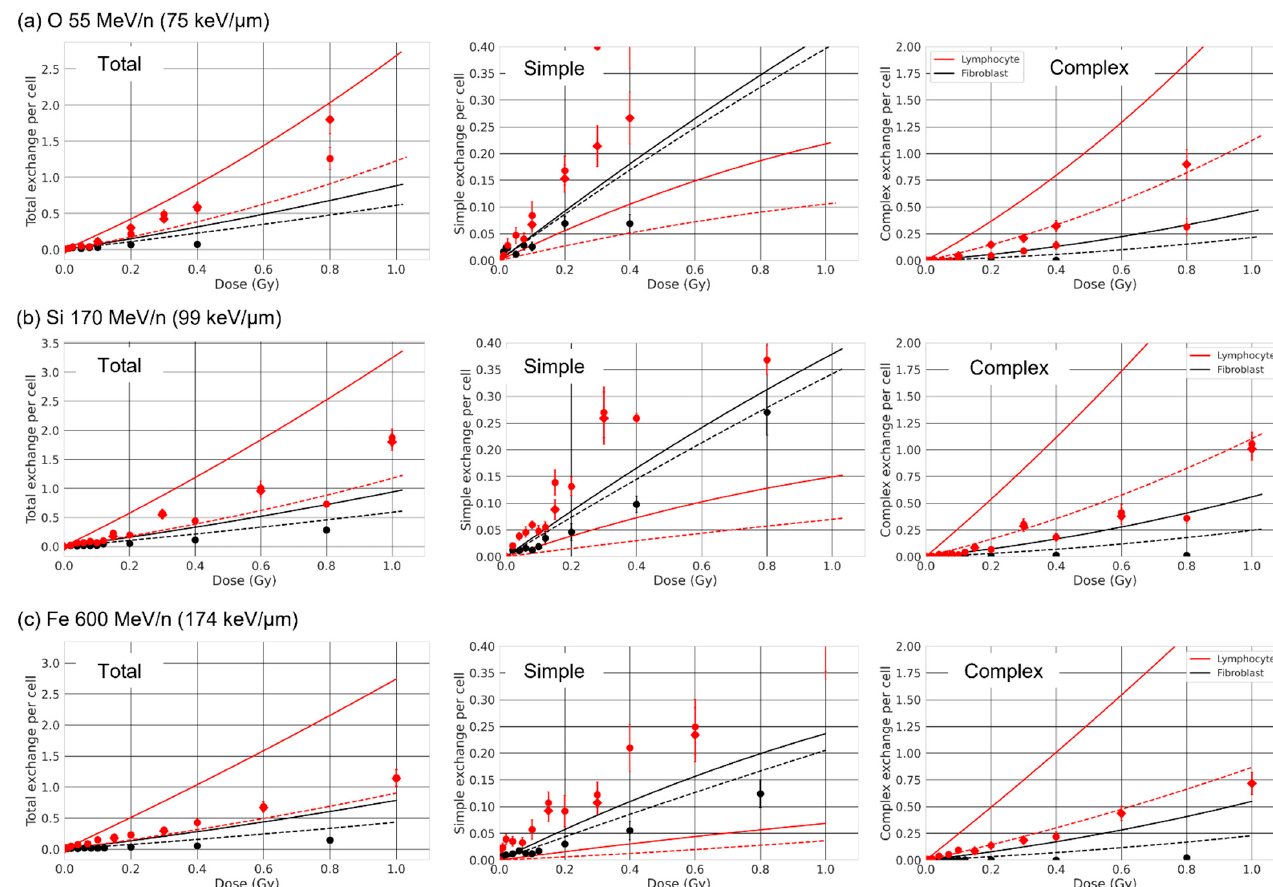
Figure 12. Comparison between experimental results and RITCARD predictions for lymphocytes (red, spherical with 𝑅 = 3 μ m) and fibroblasts 82-6 (black, ellipsoidal with 𝑥 = 𝑦 = 7.22 μ m and 𝑧 = 3 μ m) for ion beams ( a ) O 55 MeV/n, ( b ) Si 170 MeV/n and ( c ) Fe 600 MeV/n. Left to right: total, simple, and complex exchanges. The solid lines (without chromosome domain constraint) and dashed lines (with chromosome domain constraint) are the LQ fit of the results from RITCARD. Datapoints are experimental results adapted from Ref. [68] (circles) and Ref. [21] (diamonds) © 2022 Radiation Research Society. Cell sex is not reported in the studies.